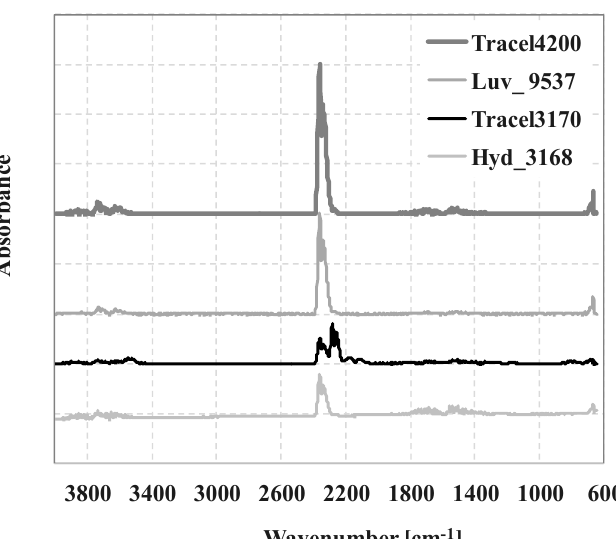
Figure 4. The Fourier transform infrared (FTIR) spectrum of foaming agents (in the 600–4000 cm − 1 range). Table 3. The results of the TGA-FTIR measurement (10 ◦ C/min, nitrogen measuring atmosphere). Foaming Agent